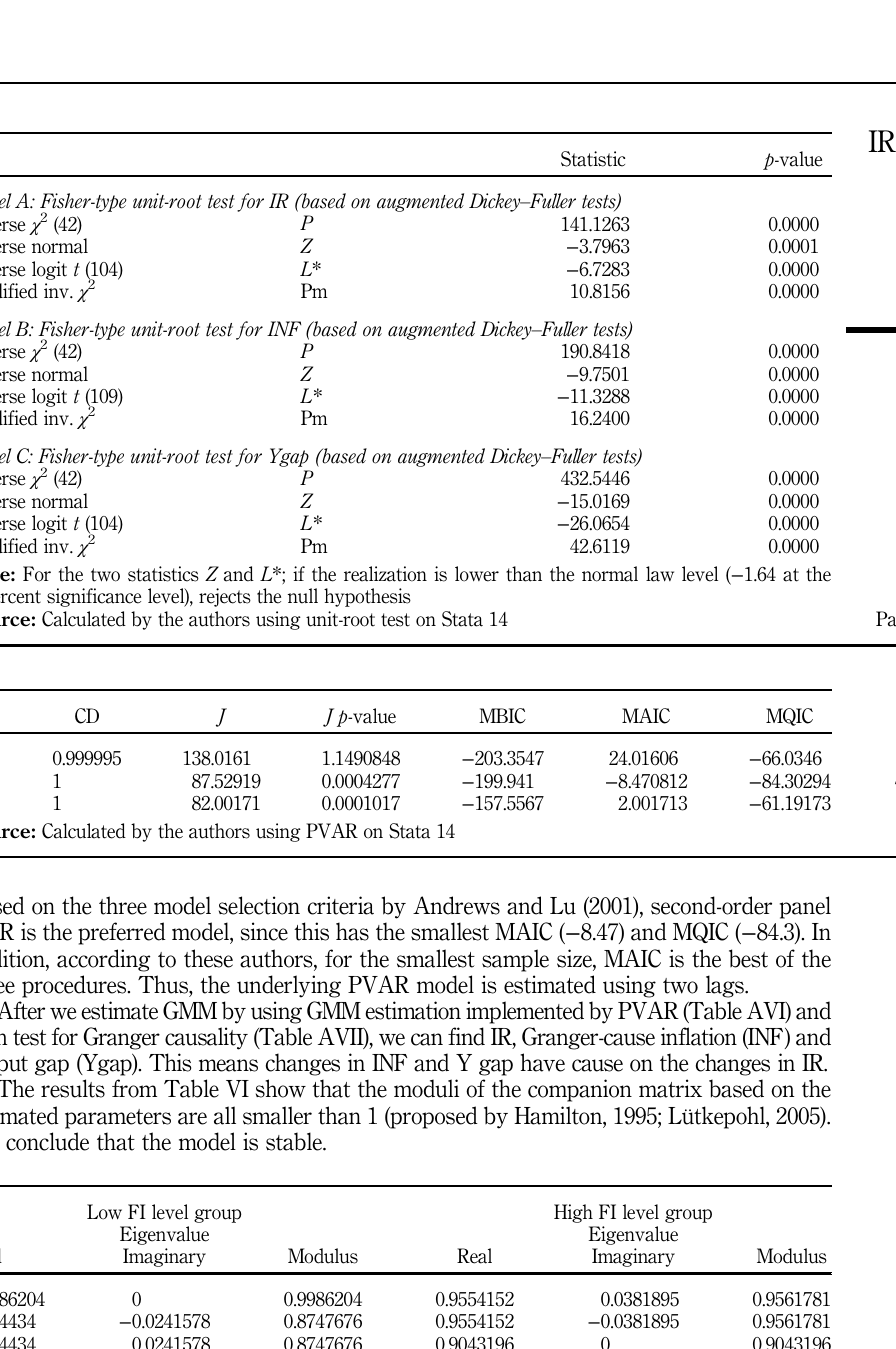
Table VI. Eigenvalue stability